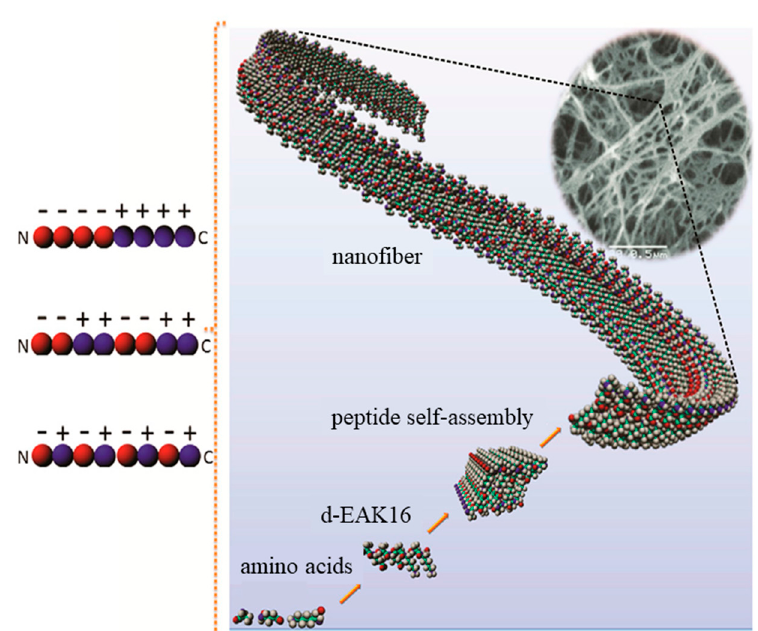
Figure 1. Self-assembly of a peptide consisting of alanine (A), glutamic acid (E), and lysine (K) (d-EAK) into nanofibers, which were then entangled into 3D scaffolds. The self-assembling process was a consequence of complementary ionic interactions between charged residues (red for negatively charged glutamic acid and blue for the positively charged lysine residues), which could have different arrangements: modulus I, − − − − + + + +; modulus II, − − + + − − + +; modulus III, − + − + − + − +). Adapted and reprinted with permission from [34,38].